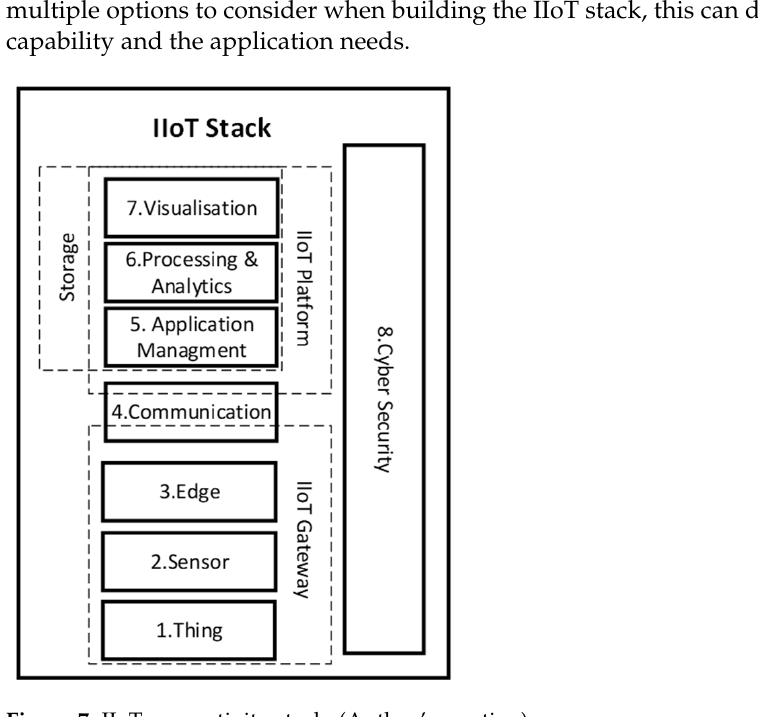
Figure 7. IIoT connectivity stack. (Author’s